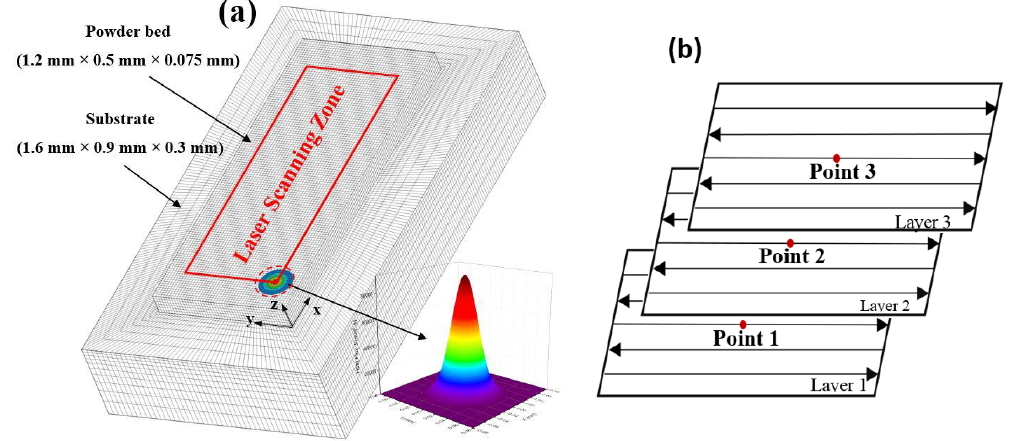
Figure 2. 3D Finite Element (FE) model and Gaussian laser energy density ( a ) and laser scanning pattern in Selective Laser Melting (SLM) process ( b ). (Point 1 at the centre of layer 1, Point 2 at the centre of layer 2 and Point 3 at the centre of layer 3 respectively).